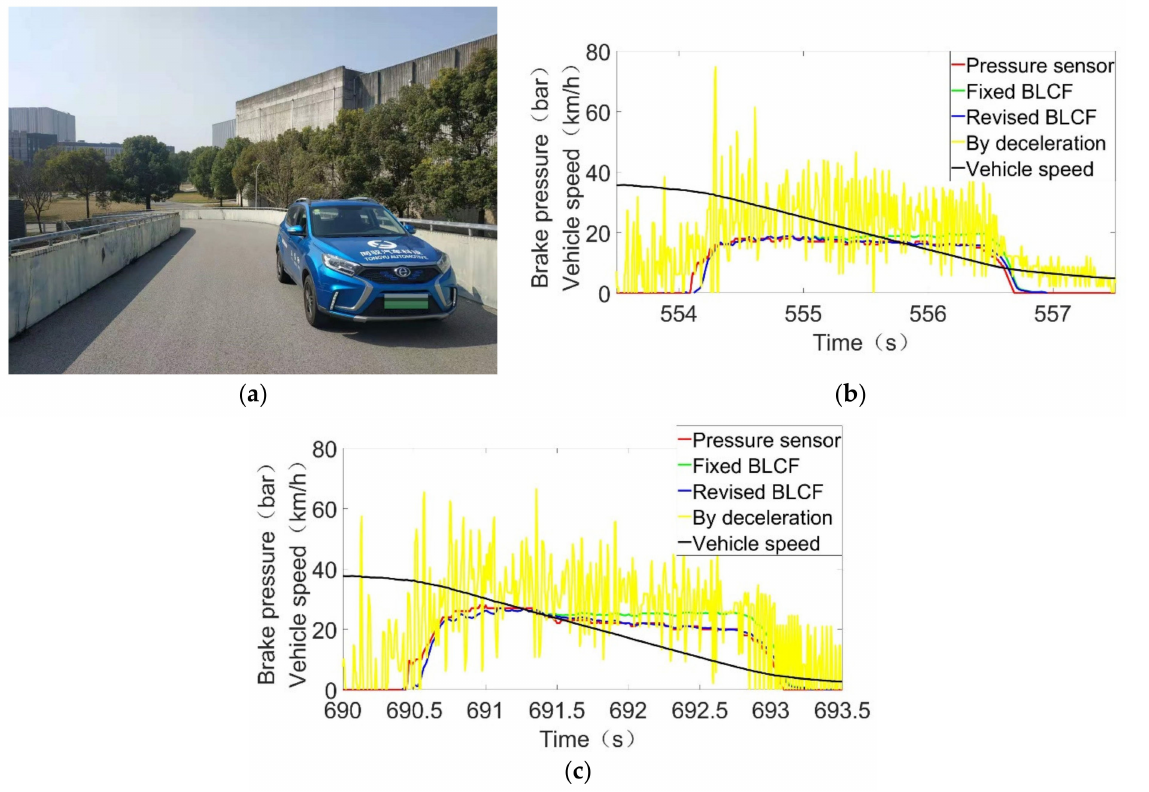
Figure 14. Test results of MCPE on the uphill: ( a ) Test vehicle on the uphill, ( b , c ) show the test